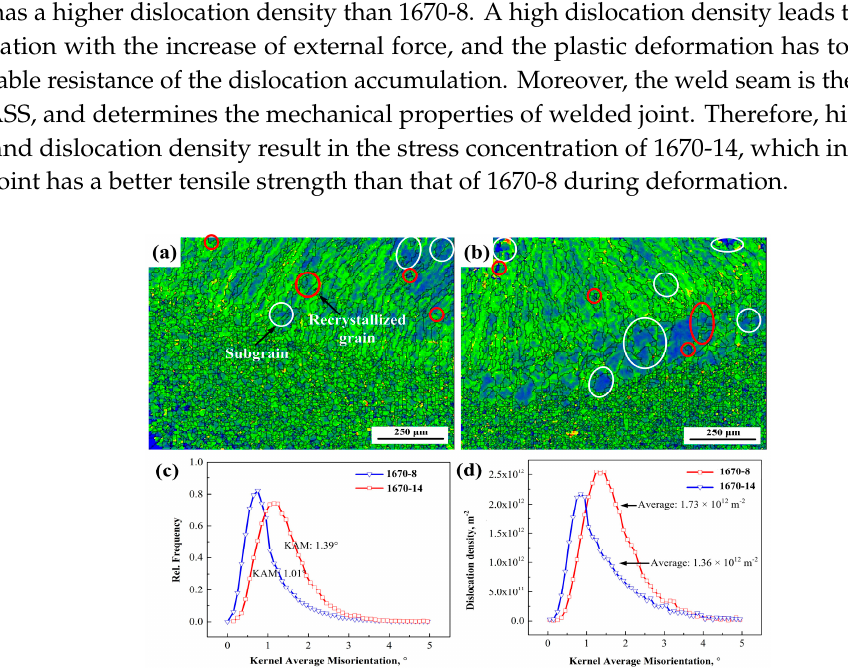
Figure 9. ( a ) Kernel average misorientation (KAM) map of 1670-8, ( b ) KAM map of 1670-14, ( c ) KAM distribution, and ( d ) dislocation density. distribution, and ( d ) dislocation